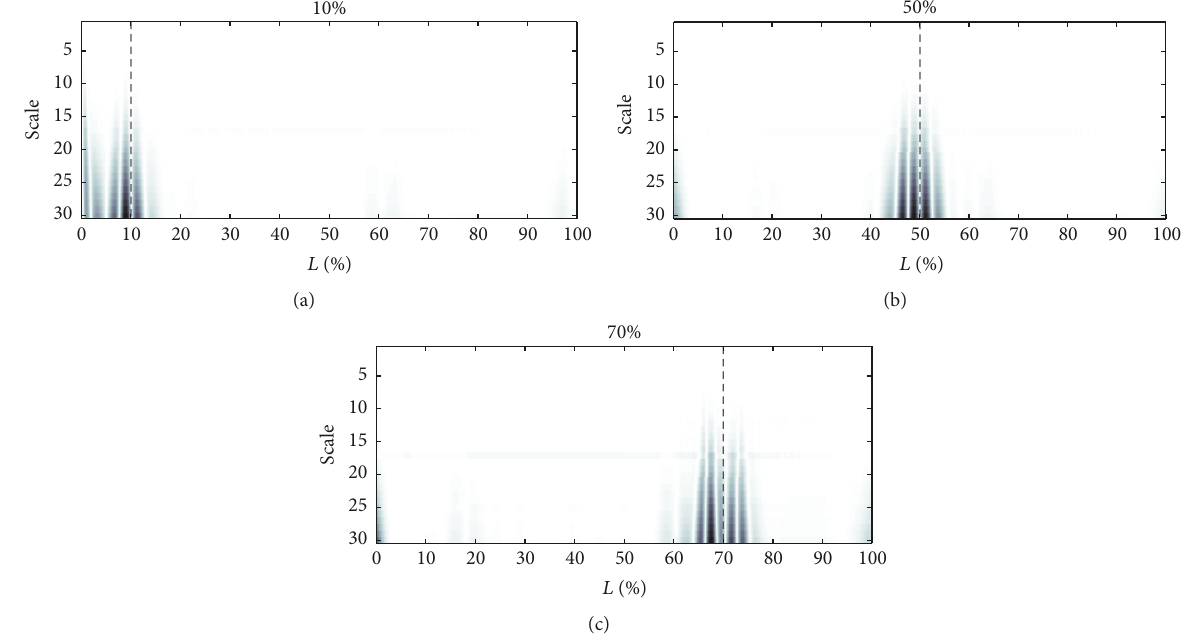
Figure 15: Numerical results of wavelet analysis in the case of three damage location